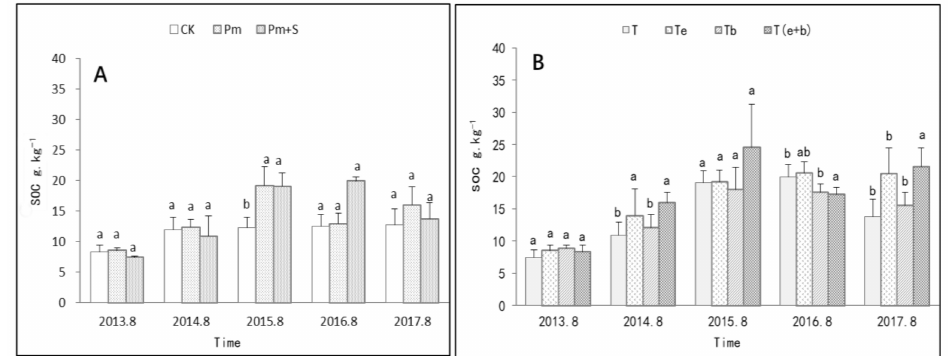
Figure 2. Dynamic change of soil organic carbon content. Bars represent standard errors. Lower case letters above each panel show statistical significance at p < 0.05. CK pig manure, S slurry, e earthworms, b bacteria, T Pm + S, Te T + earthworms, Tb T + bacteria, T(e + b) T + earthworms + bacteria. ( A ) Pig manure, biogas slurry agricultural use ( B ) Biological